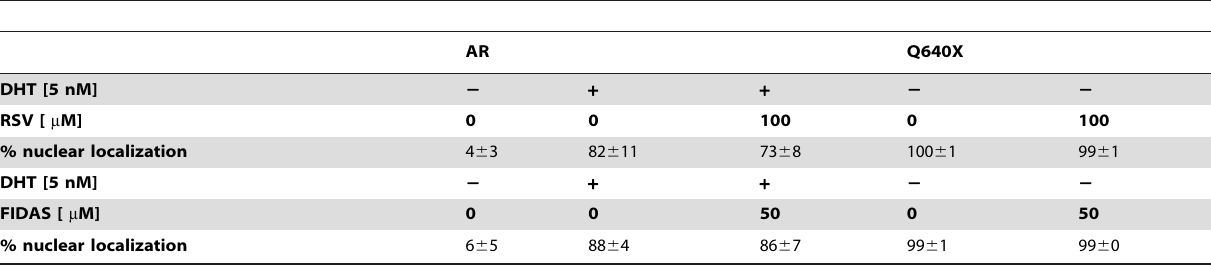
Prostate cancer cells (PC-3) were transfected with expression plasmids coding for green fluorescent AR-EosFP or Q640X-EGFP fusion proteins. Nuclear localization of AR or Q640X fusion proteins was analyzed by fluorescence microscopy. Data present the percentage of fluorescent cells exhibiting a predominantly nuclear fluorescence.